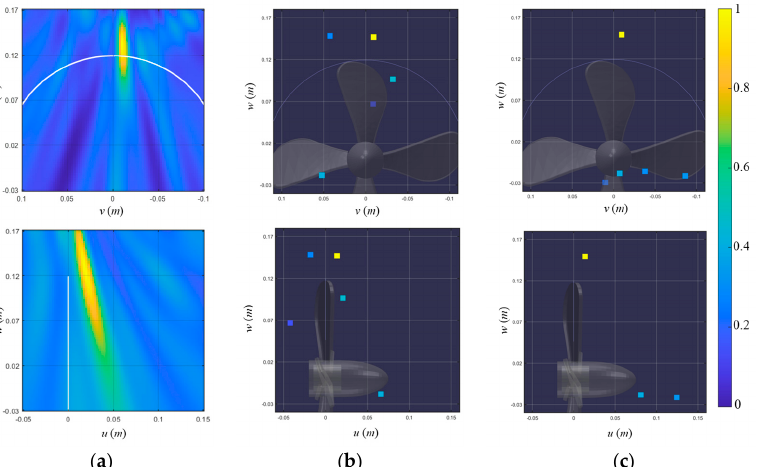
Figure 11. Localization results for the first cavitation event (signal 1) using ( a ) a conventional beamformer, ( b ) off-grid BSBL, and ( c ) pairwise off-grid BSBL. The localization results are displayed onto the 𝑣 – 𝑤 (looking from the stern side) and 𝑢 – 𝑤 (looking from the port side) planes to visualize the 3D cavitation localization results.